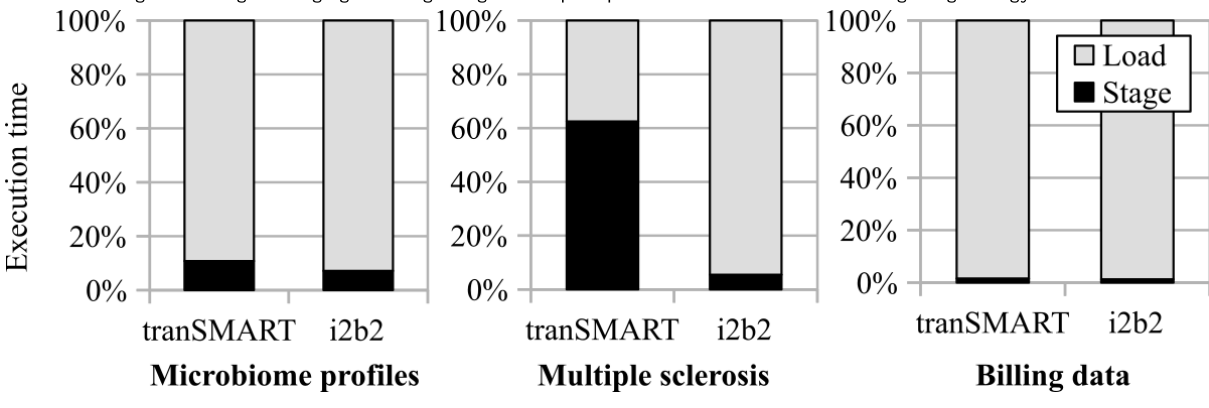
Figure 5. Percentage of loading and staging times regarding the complete process. i2b2: Informatics for Integrating Biology and the